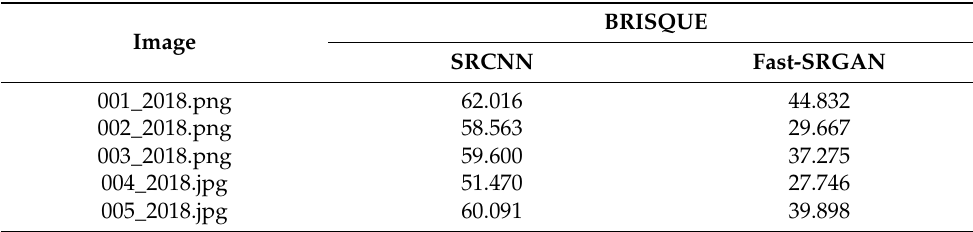
Table 3. BRISQUE measuring result: real bridge